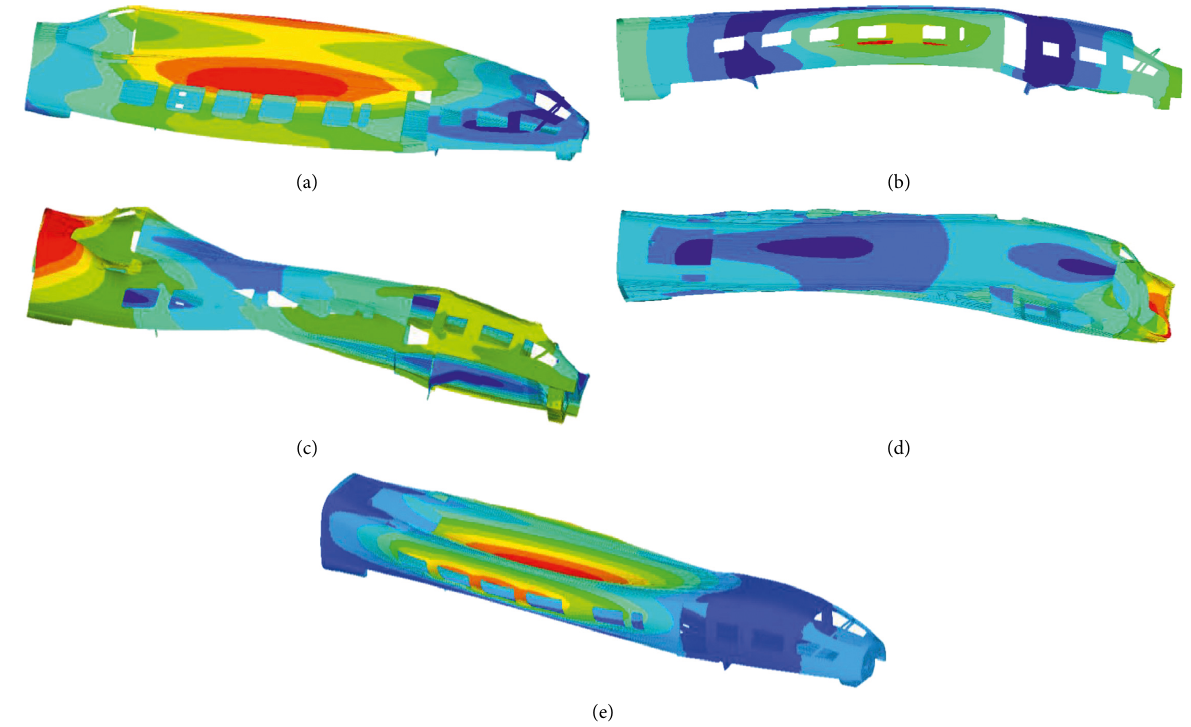
Figure 1: The eigen frequency results for the first five orders of the car body vibrations.